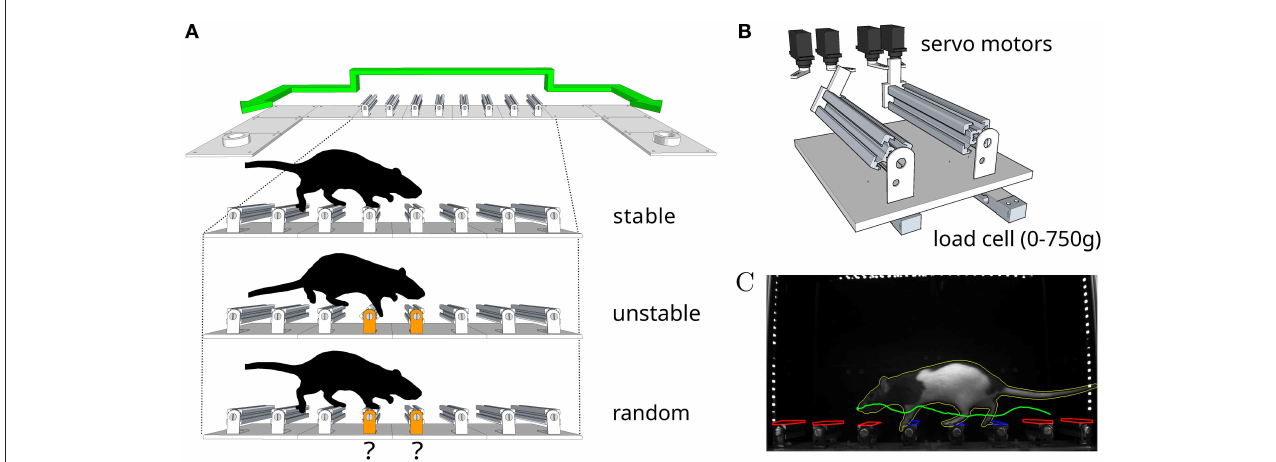
FIGURE2 An obstacle course for rodents. (A) Schematic of the apparatus and summary of the different conditions in the behavior protocol. Animals shuttle back and forth between two reward ports at either end of the enclosure. (B) Schematic of the locking mechanism that allows each individual step to be made stable or unstable on a trial-by-trial basis. (C) Example video frame from the behavior tracking system. Colored overlays represent regions of interest (red inactive, blue active) and feature traces (nose trajectory in green, body outline in yellow) extracted automatically from the